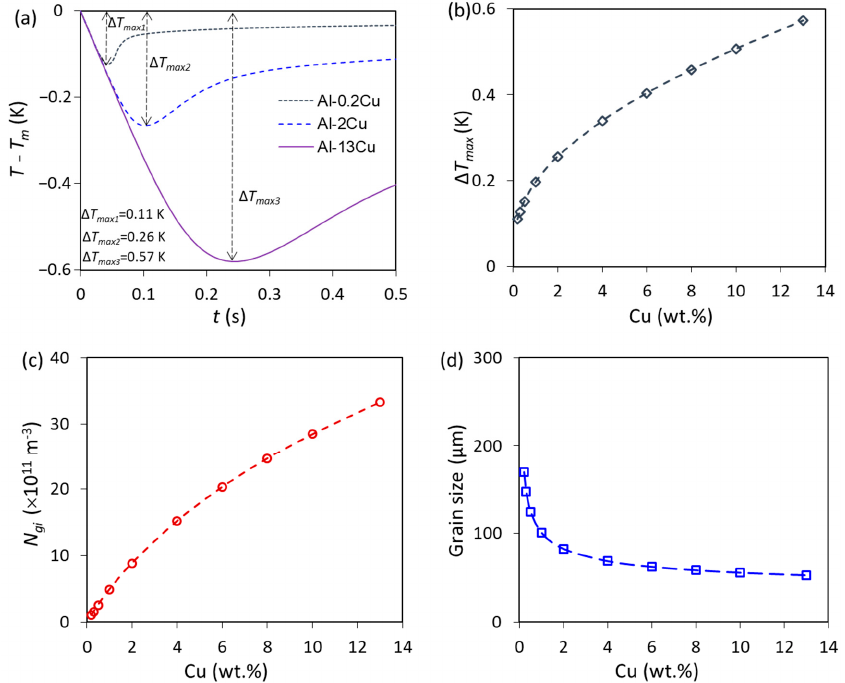
Figure 7. The calculations of Al-Cu alloys inoculated by potent TiB 2 particles ( N 0 = 1 × 10 13 m − 3 ) with a log-normal size distribution ( d 0 = 0.67 μ m and σ = 0.876) at Ṫ = 3.5 K/s [9]. ( a ) The calculated cooling curves of Al-0.2Cu, Al-2Cu and Al-13Cu alloys, showing that recalescence is delayed to a lower temperature by increasing the solute contents; ( b ) the calculated Δ T max , ( c ) the total number density of initiated grains ( N gi ); and ( d ) the predicted grain size. Reprinted with permission from Ref. [9]. Copyright 2022 Elsevier.